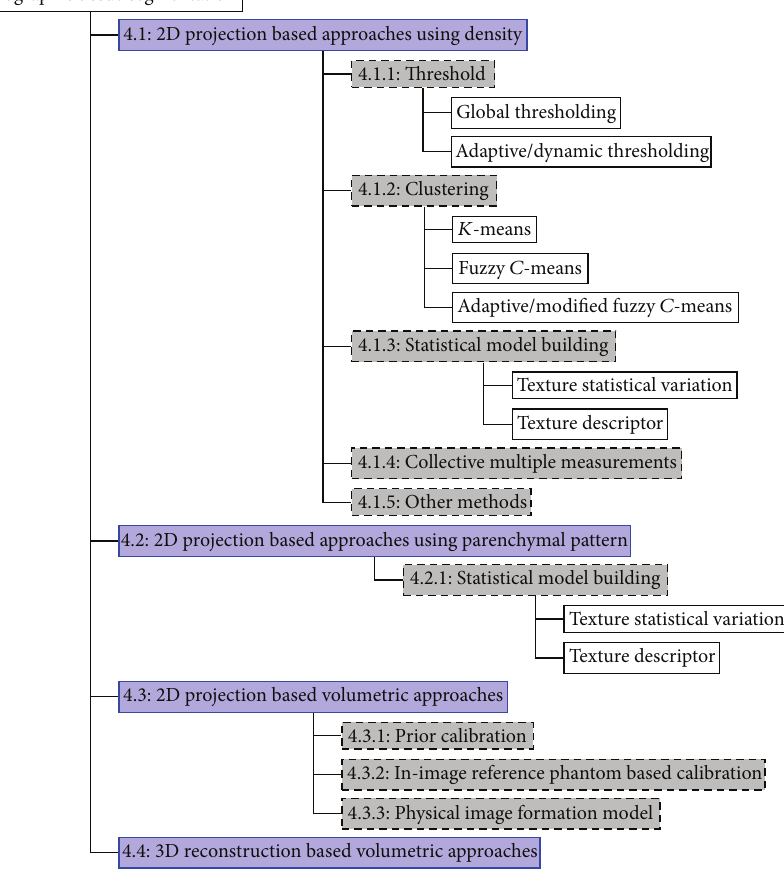
Figure 3: A tree representation for mammographic tissue segmentation categorisation based on combination (e.g., shaded in light purple) of technological advances and image modalities. Subcategorisation (e.g., shaded in light grey) is based on core segmentation